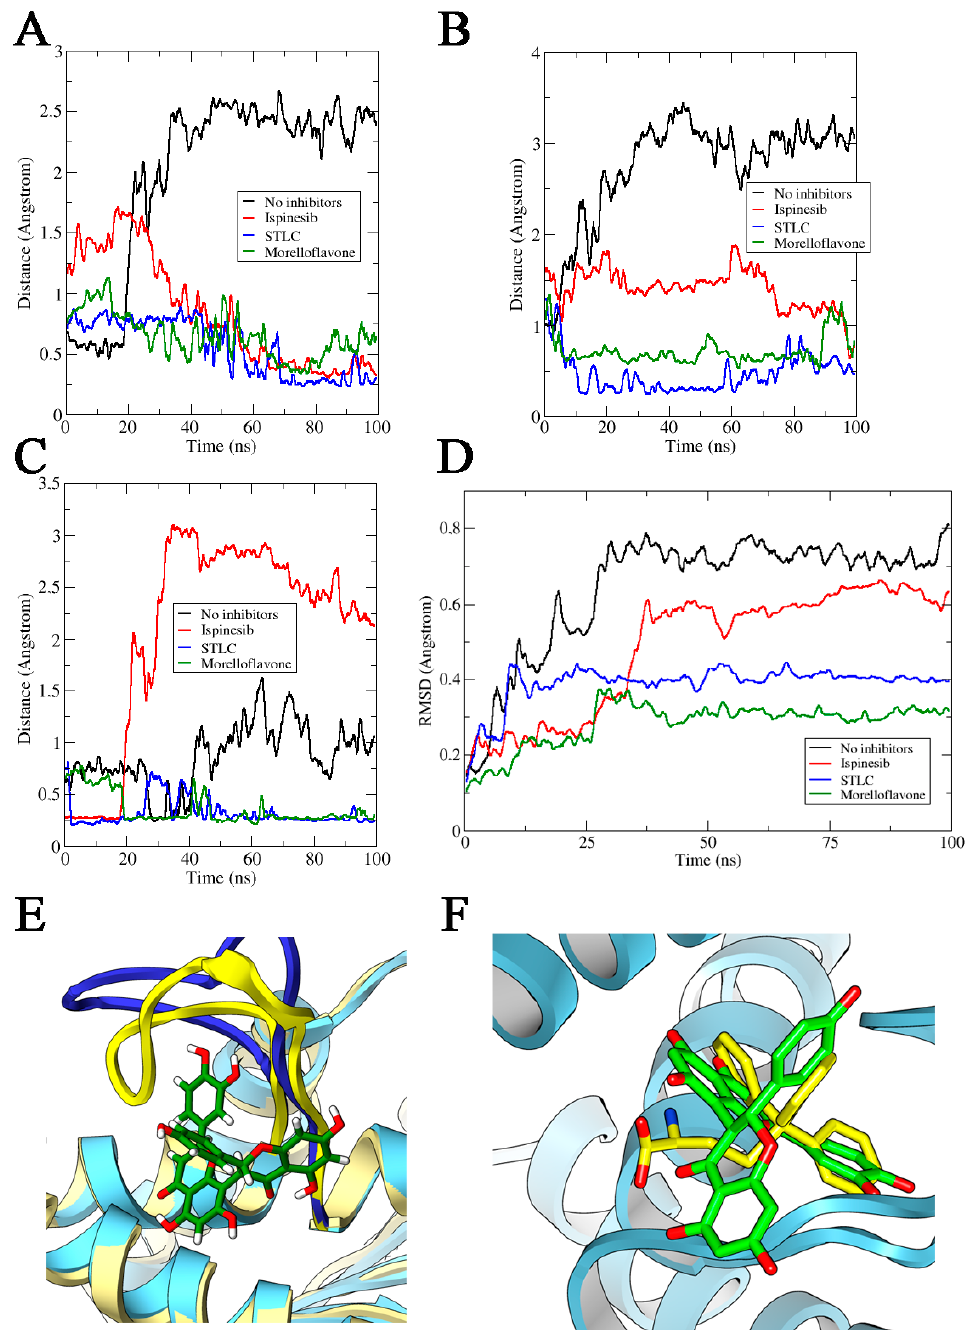
Figure 4. Distances (in Å) between Eg5 Trp127 and Glu215 residues in the presence of ( A ) ADP and ( B ) ATP. ( C ) Estimated distances (in Å) between Trp127 and Tyr211 on Eg5 in the presence of ADP and inhibitors. ( D ) RMSD of loop5 in Eg5-ADP-inhibitor complexes. ( E ) Loop5, yellow cartoon, trapped in the close conformation by inhibitor (MF, reported in green) versus without inhibitor (blue cartoon). ( F ) Comparison between final conformations of STLC (in yellow sticks) and MF (in green sticks) in complex with Eg5 (in blue ribbons) and ADP. The movement of the two inhibitors toward loop5 is comparable.